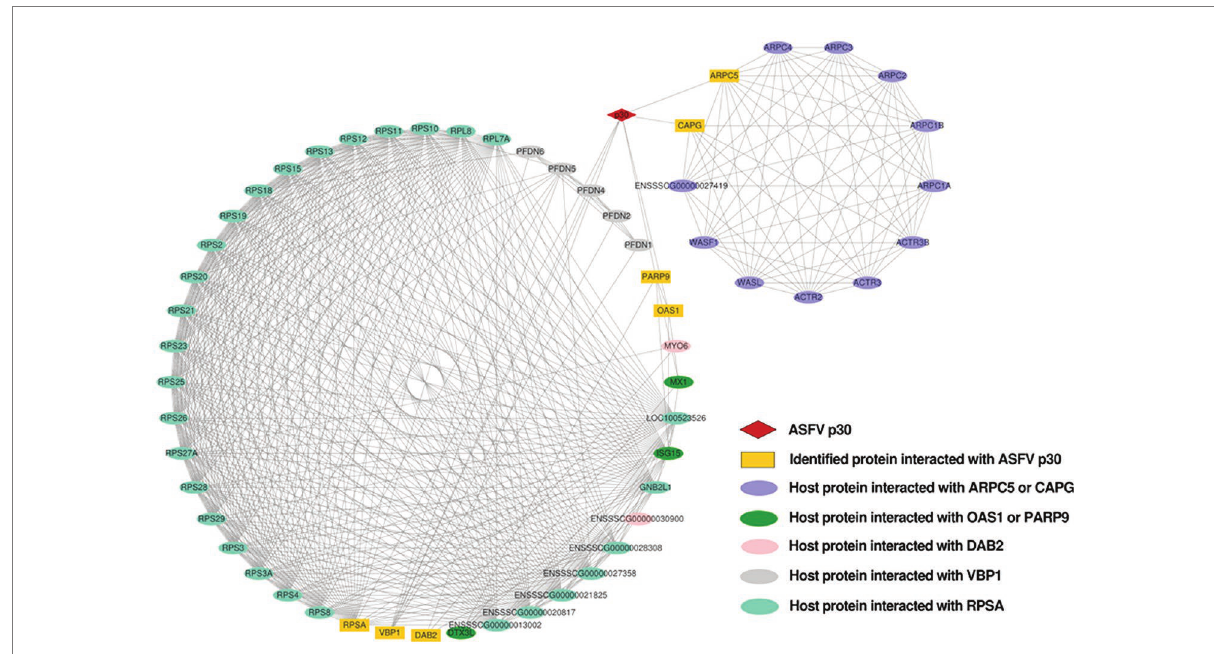
FIGURE 5 Network of interactions between ASFV p30 and host cellular proteins. Using the STRING database, a protein–protein interaction network was constructed and analyzed. Protein interactions with a total score of >0.7 from the STRING database were chosen for network development. The network analyzer tool Cytoscape v.3.8.1 was used to create and plot the map of ASFV p30-interacting proteins that interacted with the other proteins in our dataset. Straight lines between the nodes represent the interactions between proteins. Matching symbols are used to indicate distinct protein classes. NCBI gene names are used to represent proteins.